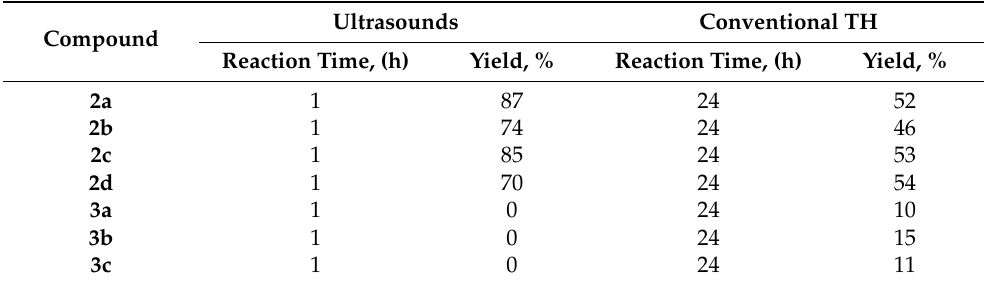
Table 1. The synthesis of brominated azatetracyclic derivatives under US irradiation and conven- tional TH. Ultrasounds Conventional TH Compound Reaction Time, (h) Yield, % Reaction Time, (h) Yield,